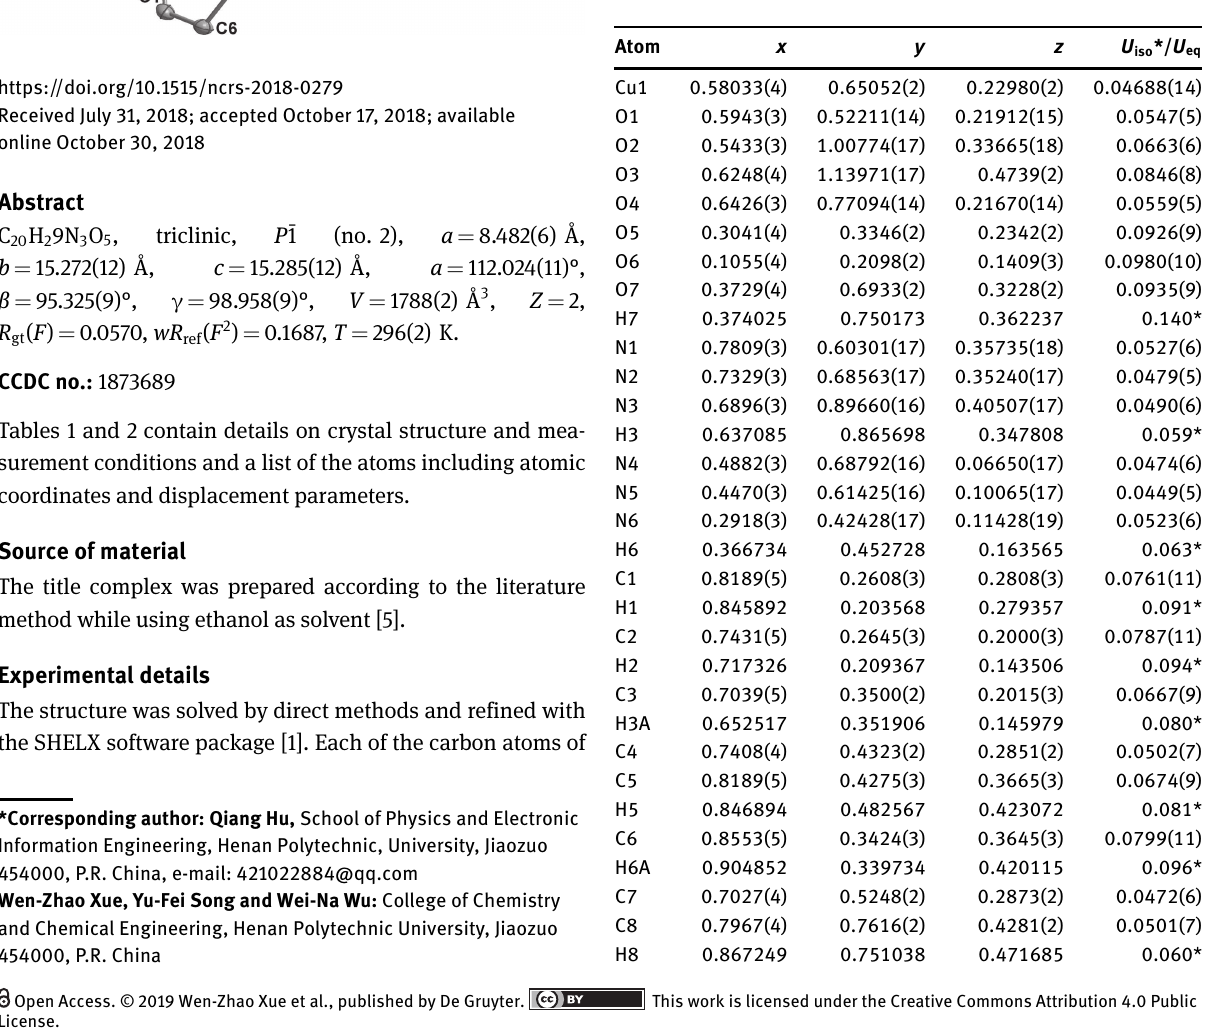
Table 2: Fractional atomic coordinates and isotropic or equivalent isotropic displacement parameters (Å 2